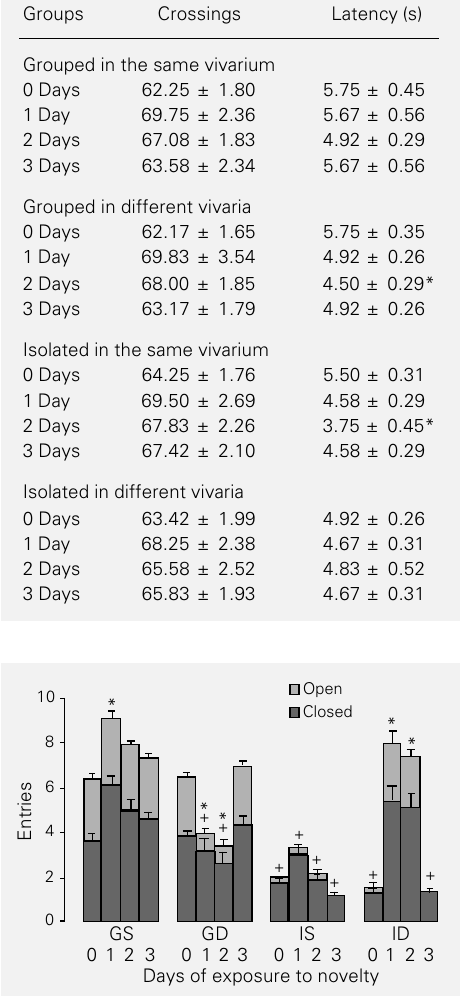
Table 2 - Number of square crossings in the arena and latency of the first entry. Data are reported as mean ± SEM. The groups are divided according to the number of days of expo- sure to novelty. *P<0.05 compared to the corre- sponding 0-day exposure group (Dunnett multiple comparisons test).